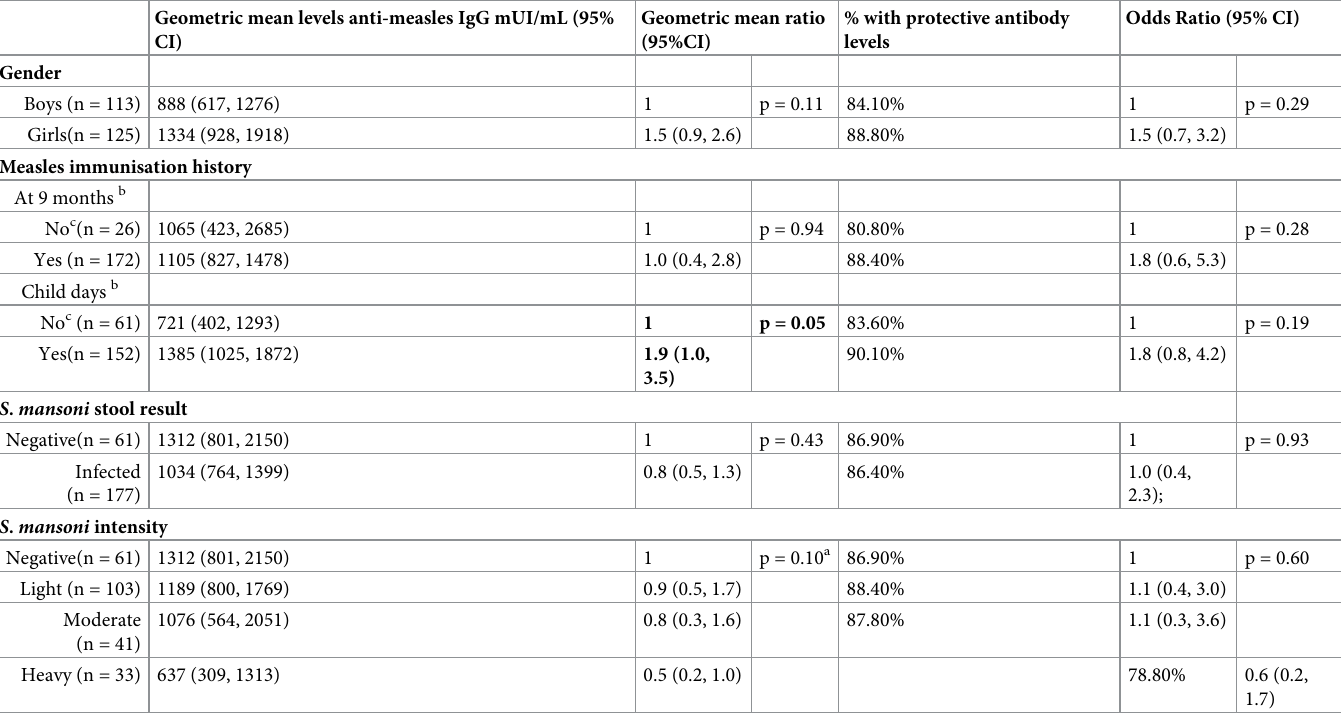
Table 2. Crude associations between participant characteristics and anti-measles IgG levels at